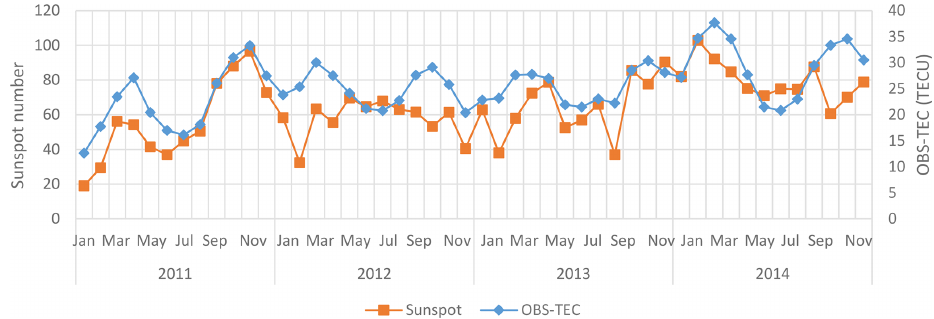
Figure 10. Monthly variation in OBS-TEC with sunspot number, R z , at Birnin